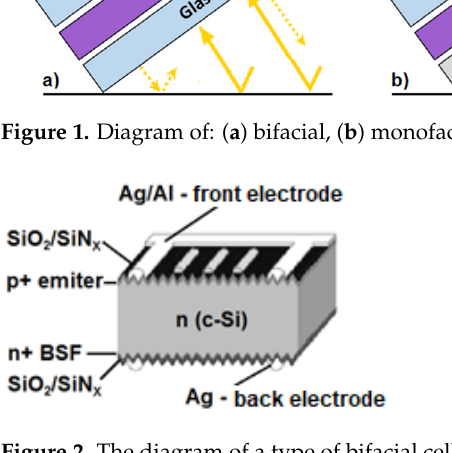
Figure 2. The diagram of a type of bifacial cell p + -n-n + [2].